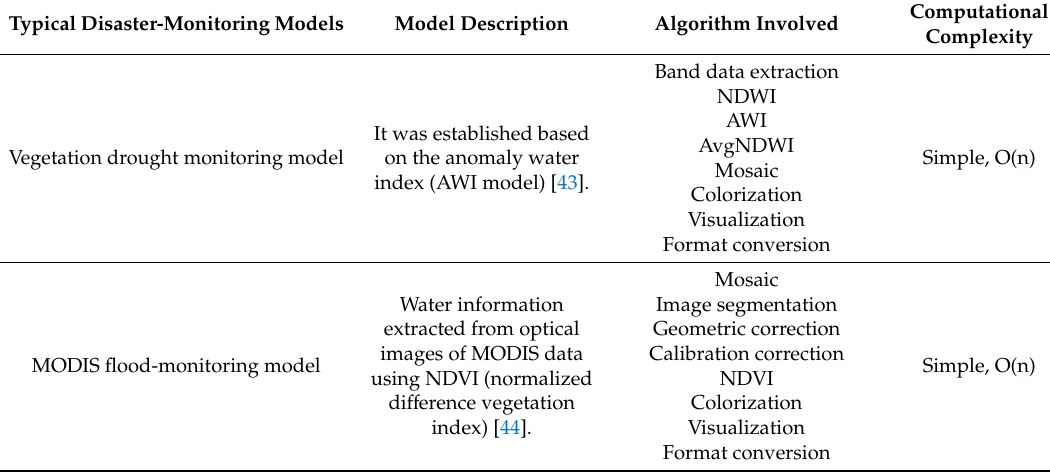
Table 1. Definition, algorithms, and features of five typical disaster-monitoring models mentioned in this